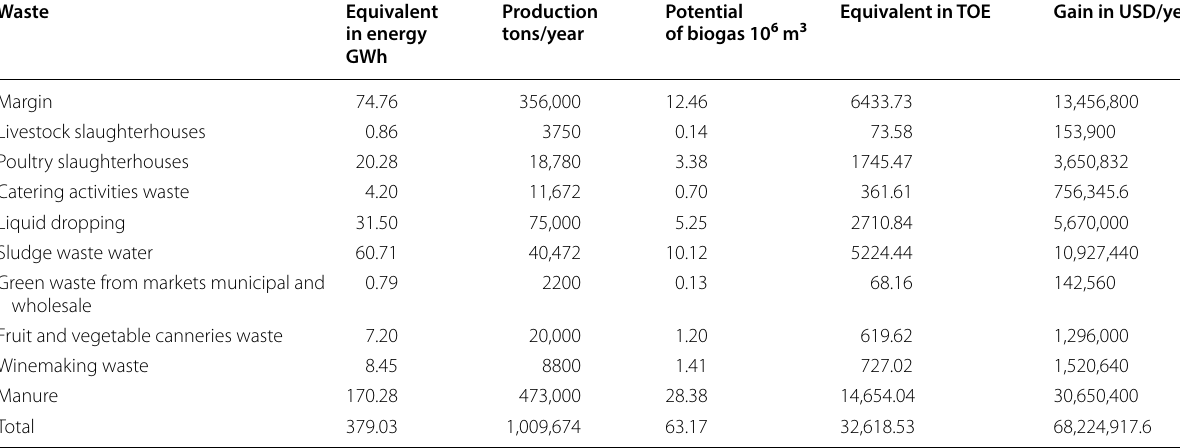
Table 3 Potential of biogas he Northwest of